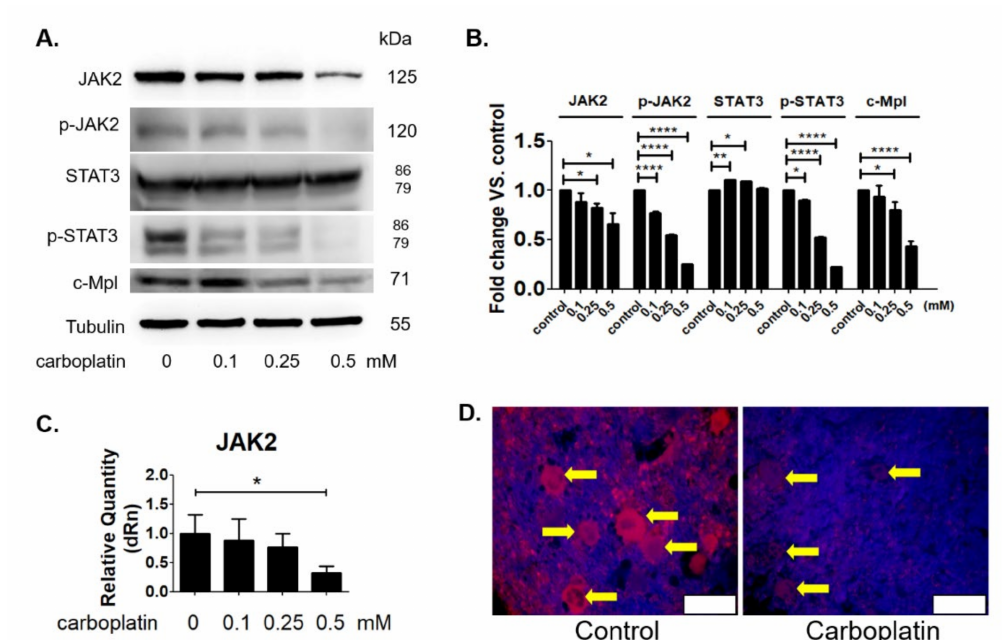
Figure 5. Carboplatin suppressed JAK2 and STAT3 activation in megakaryocytes. ( A , B ) MEG-01 cells were treated by carboplatin dose-dependently and the expressions of JAK2, p-JAK2, STAT3, p-STAT3 and c-Mpl were analyzed by western blot method and ( C ) the JAK2 mRNA expression was analyzed by RT/real-time PCR. ( D ) The JAK2 expression was analyzed in bone marrow sections prepared from control and carboplatin-treated rats at the sixth day by immunohistochemistry. Megakaryocytes were indicated by yellow arrow and the JAK2 expression was revealed by red fluorescent signal.